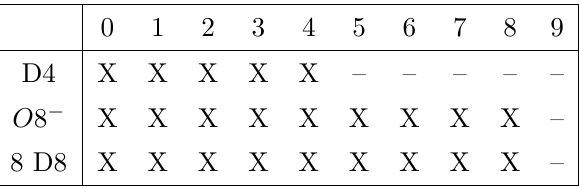
Table 22. Type I’ brane con(cid:12)guration for the 5d Sp(1) gauge theory with 8